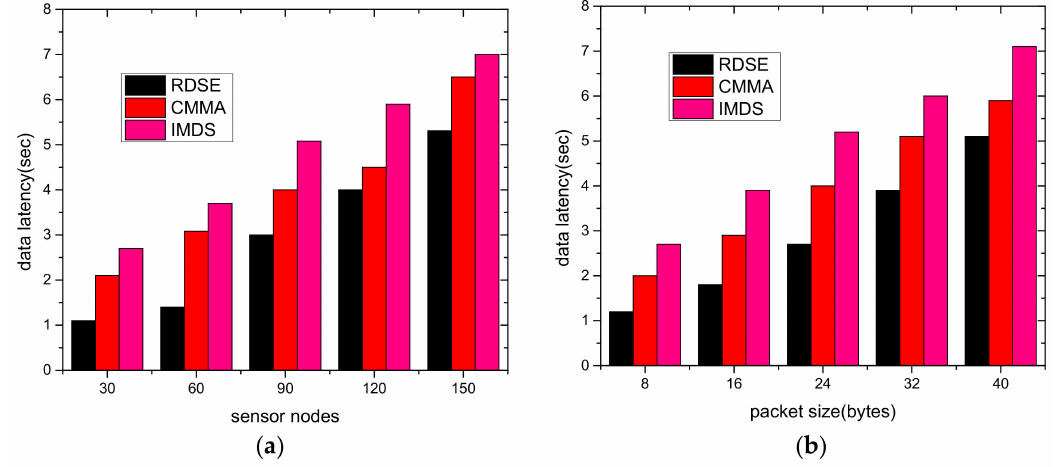
Figure 5. Data delay with ( a ) varying sensors “ 30–150” and ( b ) varying packet sizes “8–40